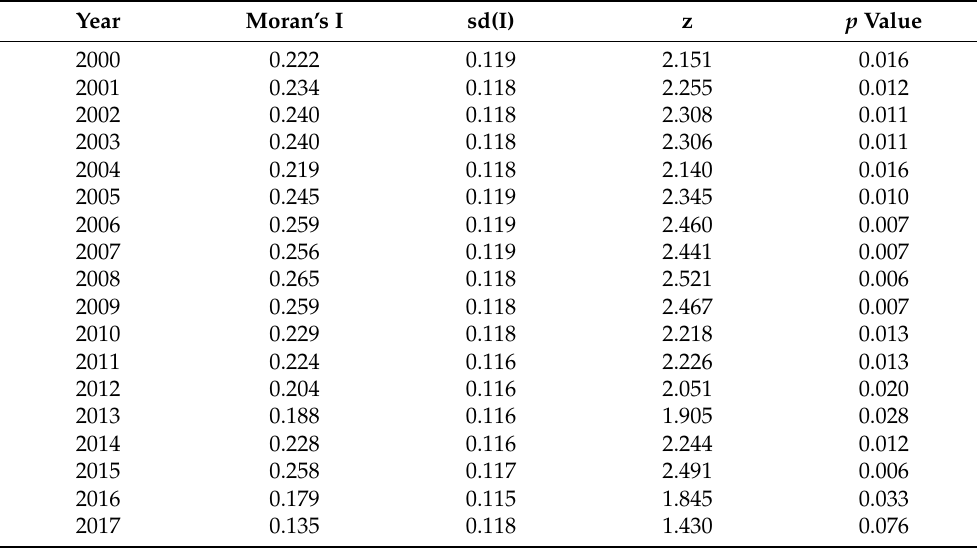
Table 1. Moran’s I of environmental